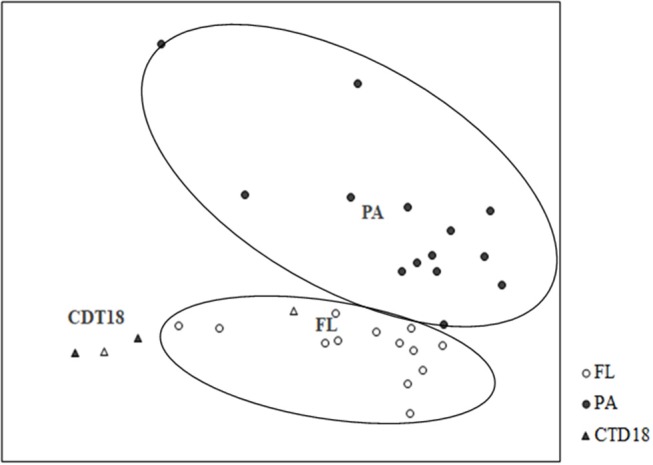
Grouping of communities according to Bray-Curtis distances using non-linear multidimensional scaling. PA and FL were separated into two groups.